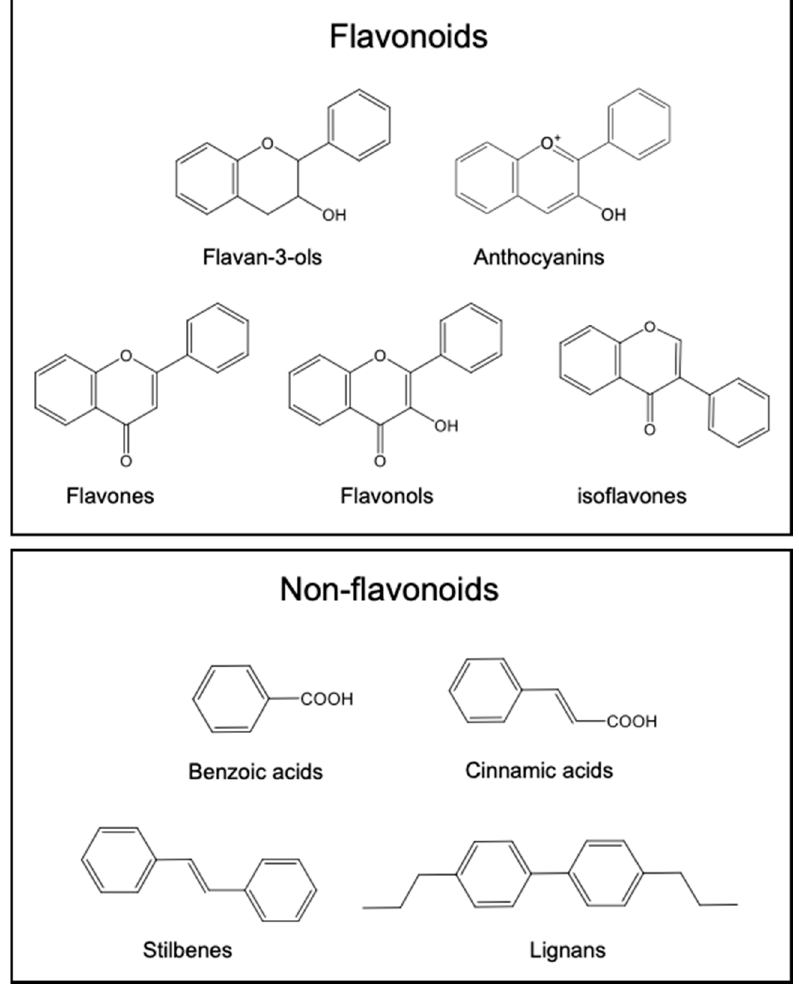
Figure 2. Core structures of the main classes of plant phenolic compounds.